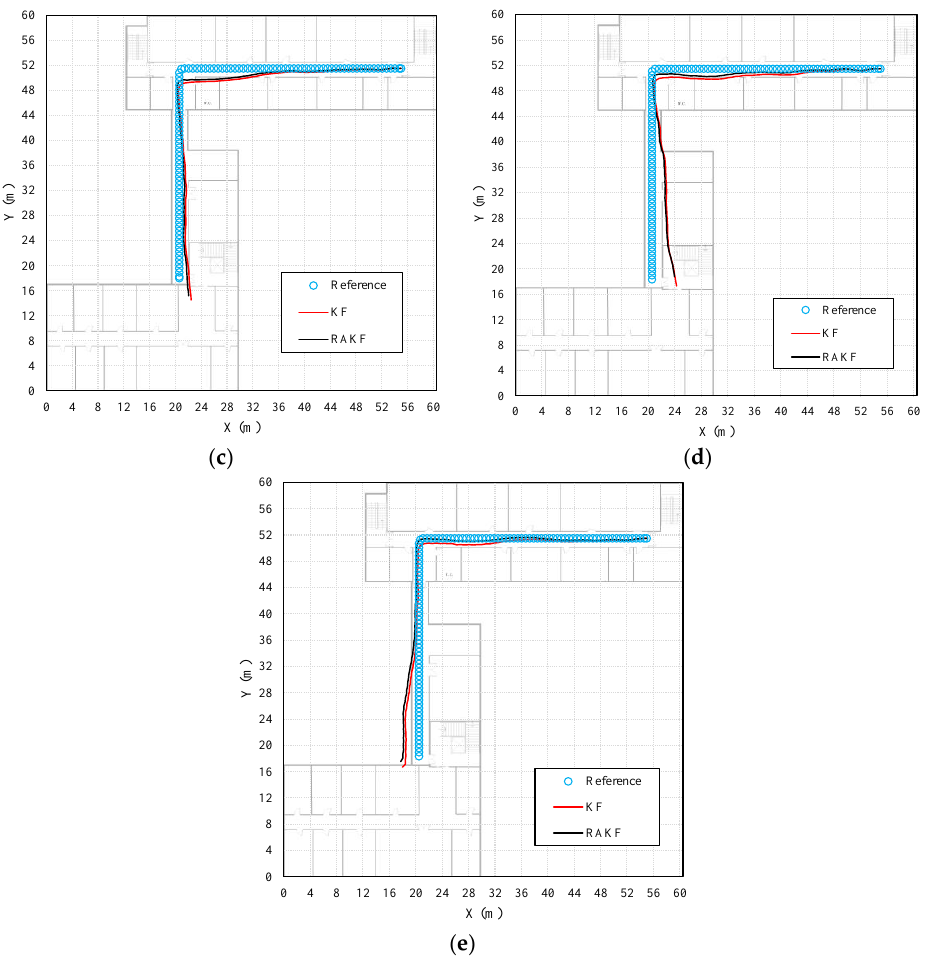
Figure 11. Comparisons of the performances on location tracking of KF and RAKF regarding five participants, ( a ) participant 1, ( b ) participant 2, ( c ) participant 3, ( d ) participant 4, and ( e ) participant 5.